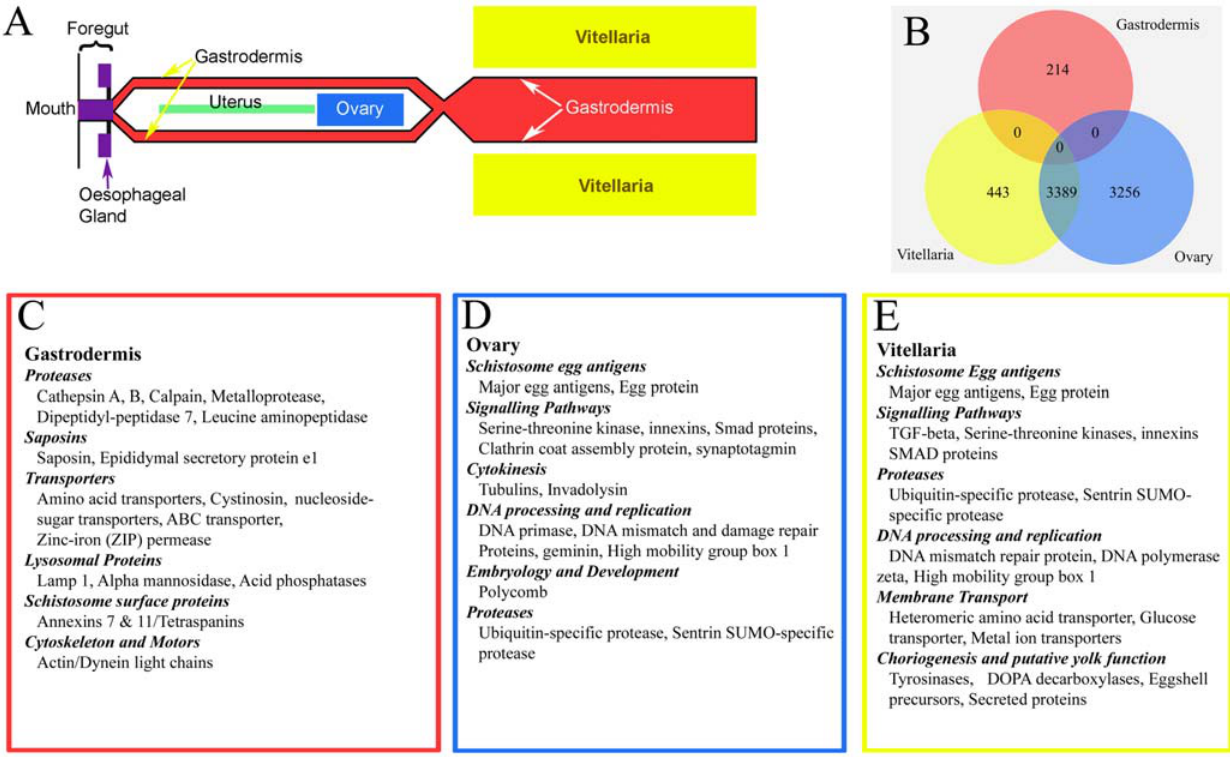
Figure 2. Microarray analysis of microdissected tissues of female S.japonicum . (A) A two-dimensional model of the arrangement of major organ systems of female schistosomes, showing relative location of the three tissues dissected here. (B) Venn diagram outlining the number of probes that were detected at 2 fold or greater in each tissue type and the degree of overlap in expression of those genes between and among tissues. (C–E). Lists of example genes enriched for each tissue. These lists are selected from full lists (Table